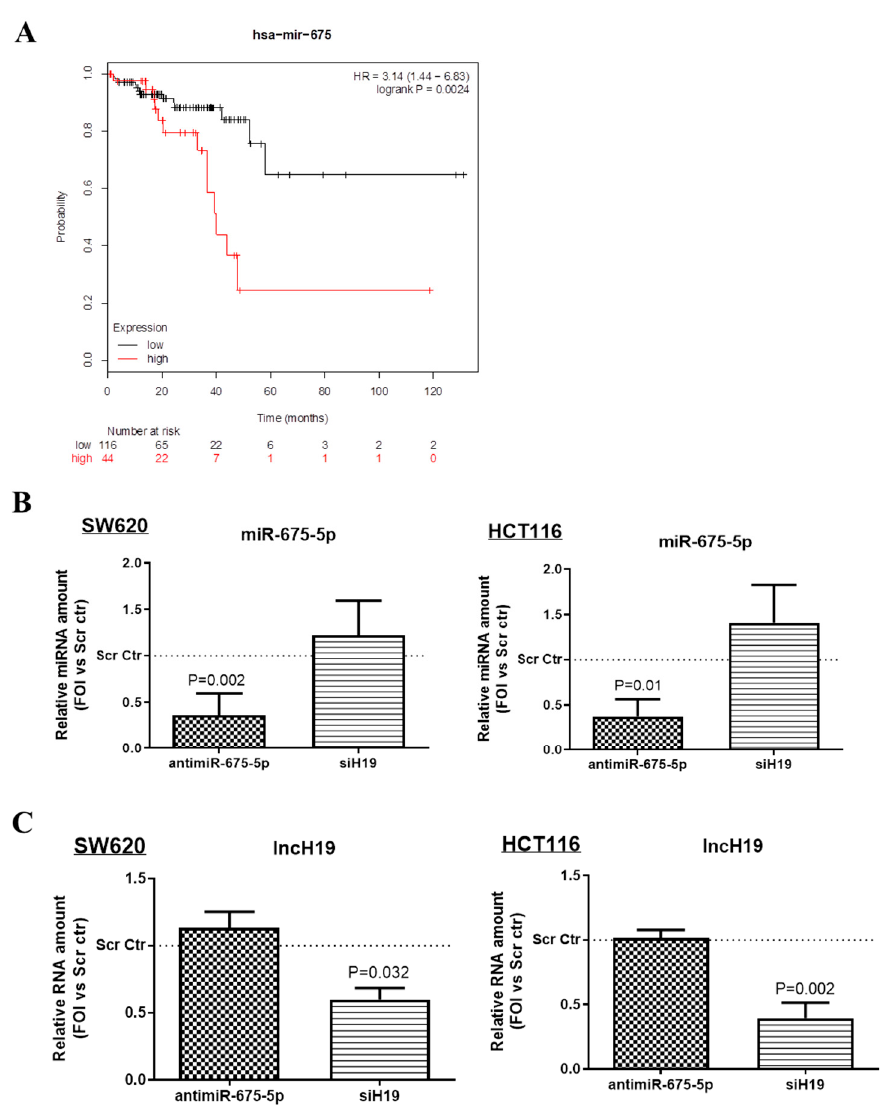
Figure 2. MiR-675-5p regulation ( A ) Kaplan–Meier curve for overall survival in the cohort of 160 rectal cancer patients. The plot was drawn by using the online Kaplan–Meier plotter tool. Patients were divided into low and high expression groups based on an upper-tertile cut off value of 20. ( B ) Real-time PCR for miR-675-5p in SW620 (on the left) and HCT116 (on the right) transfected with AntimiR-675-5p, siH19 or relative scrambled negative control and subjected to 18 h of hypoxic stimulation. ( C ) Real-time PCR for lncH19 in SW620 (on the left) and HCT116 (on the right) transfected with AntimiR-675-5p, siH19 or relative scrambled negative control and subjected to 18 h of hypoxic stimulation. MiR-675-5p data were normalized for RNU6 (RNA, U6 Small Nuclear) while lncH19 levels were normalized for β -actin, ∆∆ Ct is expressed as fold of increase (FOI) with respect to scrambled negative control. Data are expressed as the mean ± SD of three independent experiments and p -values are indicated in the